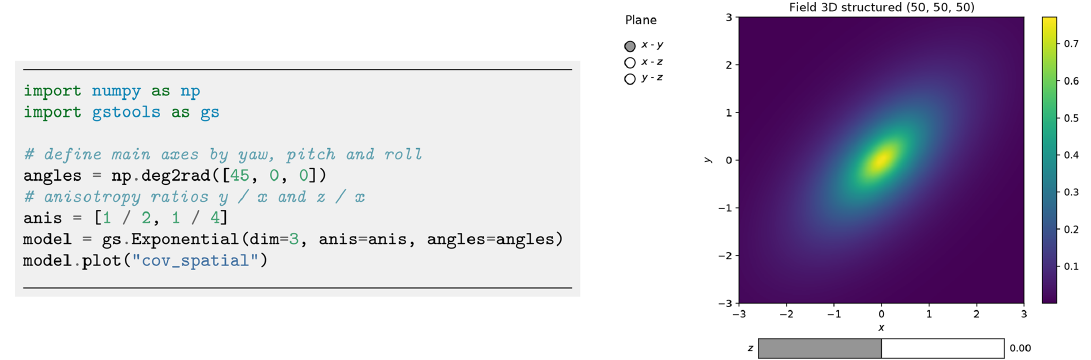
Figure 3. Spatial covariance structure of an anisotropic exponential model in 3D plotted with the built-in interactive routines of GSTools . The example shows an eighth turn on the xy plane with anisotropy factors ( 1 / 2 , 1 / 4 ) . Rotation angles are given in